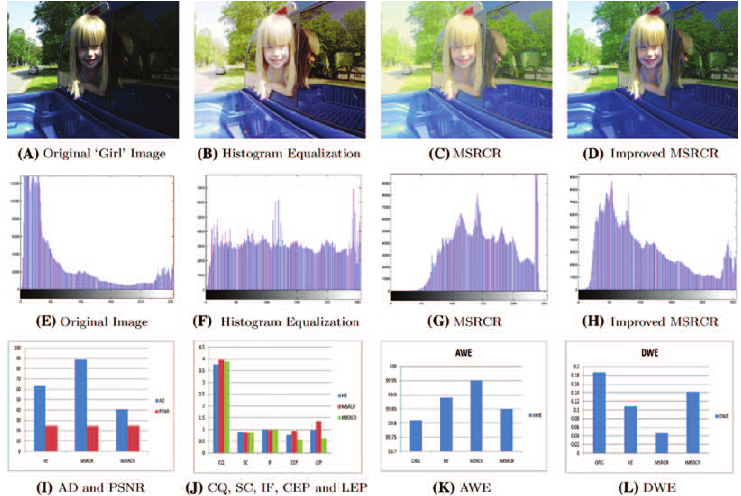
Figure 8. (Top) Image Enhancement Methods. (Middle) Histogram Plots: x -axis, Intensity Levels Ranging from 0 to 255; y -axis, Total Number of Pixels. (Bottom) Conventional Metrics and Proposed AWE and DWE Metrics. The “Girl” Image has been Downloaded from